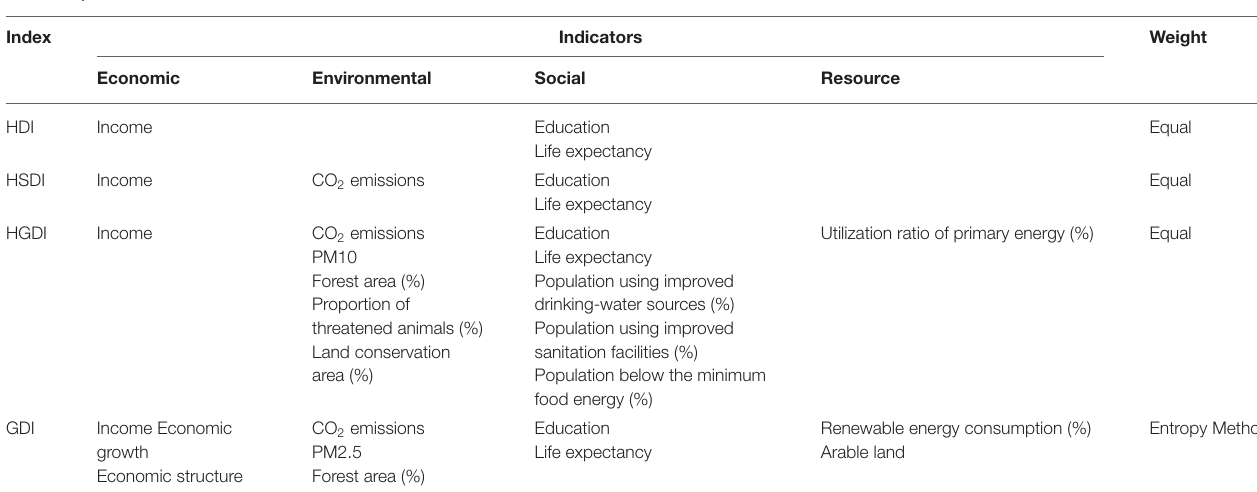
TABLE 5 | The relation and difference of